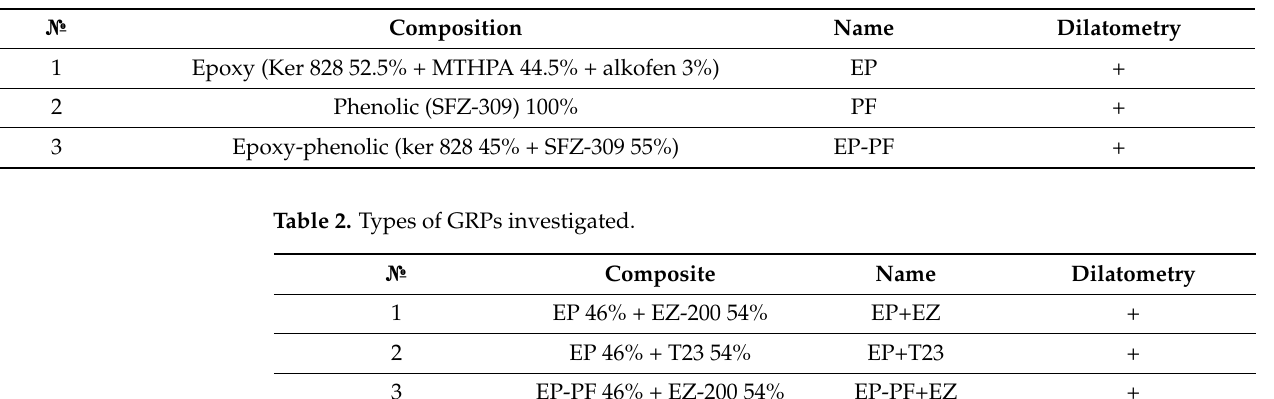
Table 1. Types of binders investigated.